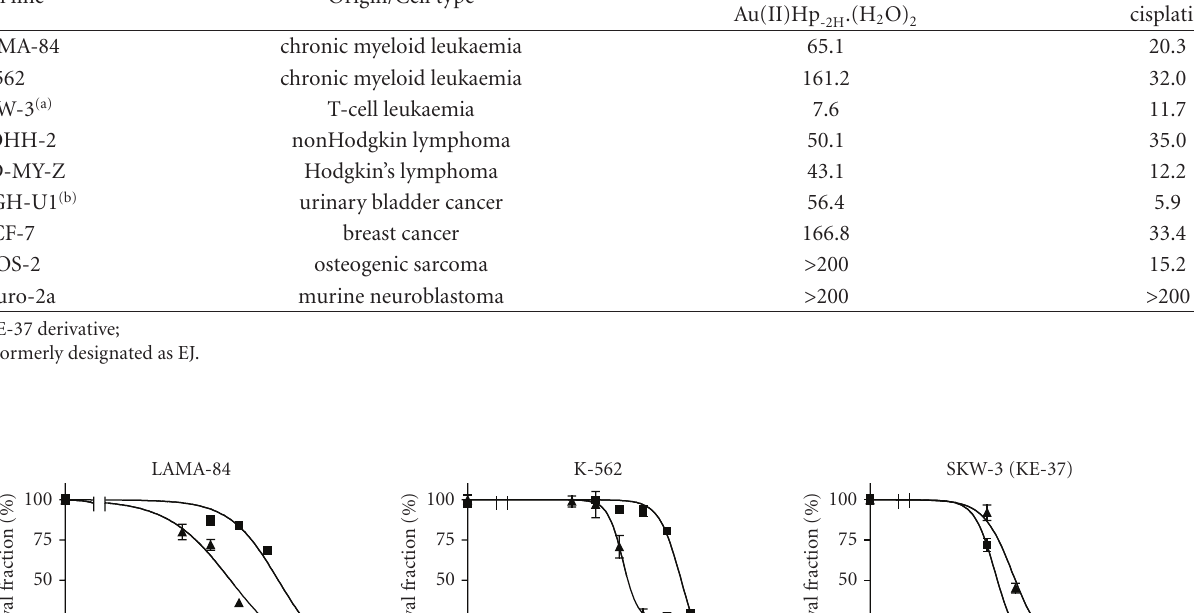
.(H 2 O) and cisplatin against a panel of tumor cell lines assessed after 72-hour exposure (MTT-dye 2 -2H